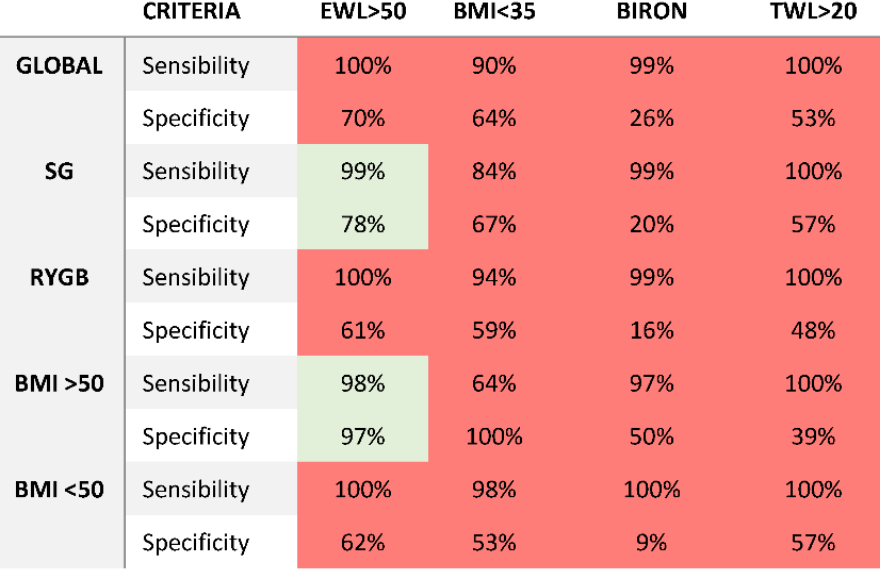
Figure 4. Sensitivity and specificity (expressed as percentages) of 4 criteria for weight loss success. Green: useful criteria with a sensitivity and specificity >70%. Red: inadequate criteria with sensitivity and specificity or specificity <70%. In Figure 5, we expressed the results of the sensitivity and specificity analysis for TWL > 20% as the definition of the real success. Weight loss criteria ≥ 50%EWL and alter- able weight loss >35% were the most adequate criteria as their specificities and sensibility were far above >80%. Alterable weight loss presented the highest specificity rates in all the subgroup analysis. Biron criteria showed good specificity and sensibility in the stratified analysis per surgery technique but worse results in the stratified analysis per initial BMI.